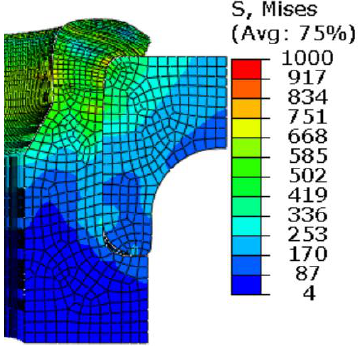
Figure 19. Equivalent stress contour plot after springback.